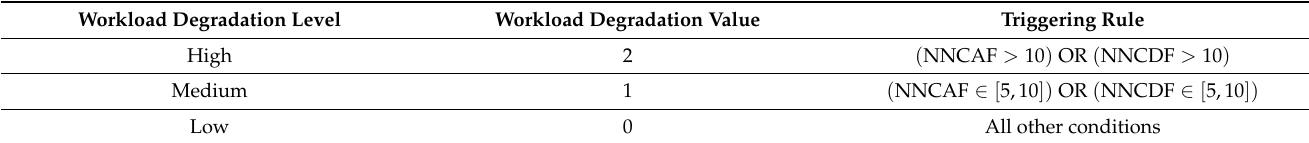
Table 10. Workload degradation